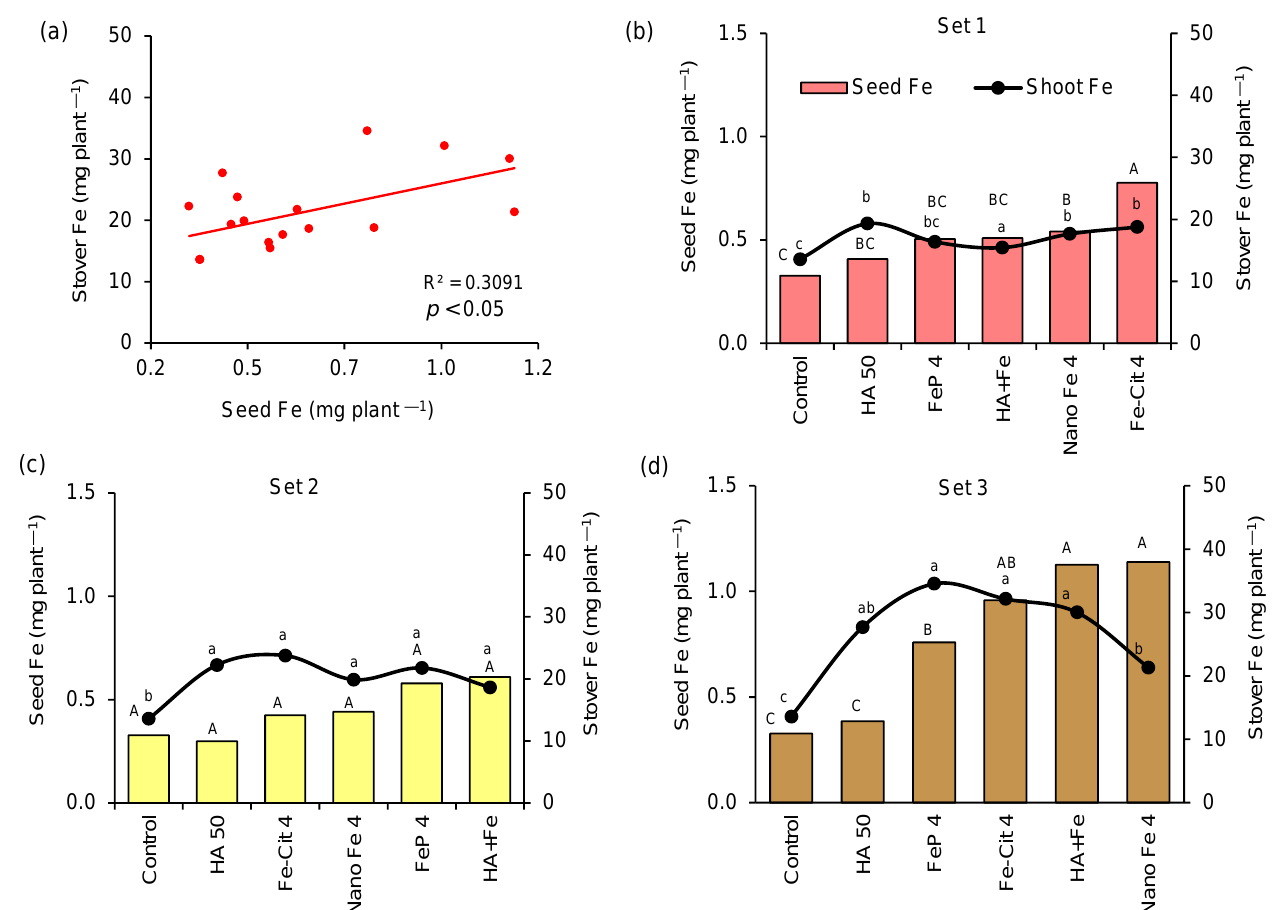
Figure 6. Influence of foliar application of Fe compounds on ( a ) a linear regression between the seed Fe and straw Fe contents in soybean (values are means of all 3 sets) and ( b – d ) seed Fe contents and stover Fe contents. Data correspond to means ± Sem ( n = 5). The plants of set 1 and set 2 received single sprays in the flowering and pod-filling stages, respectively, while set 3 plants were sprayed in both stages. Each set was analyzed separately using a one-way ANOVA, and the least significant difference was calculated. Means with same letter (uppercase for grain Fe content and lowercase for straw Fe content) were not significantly different at p < 0.05.